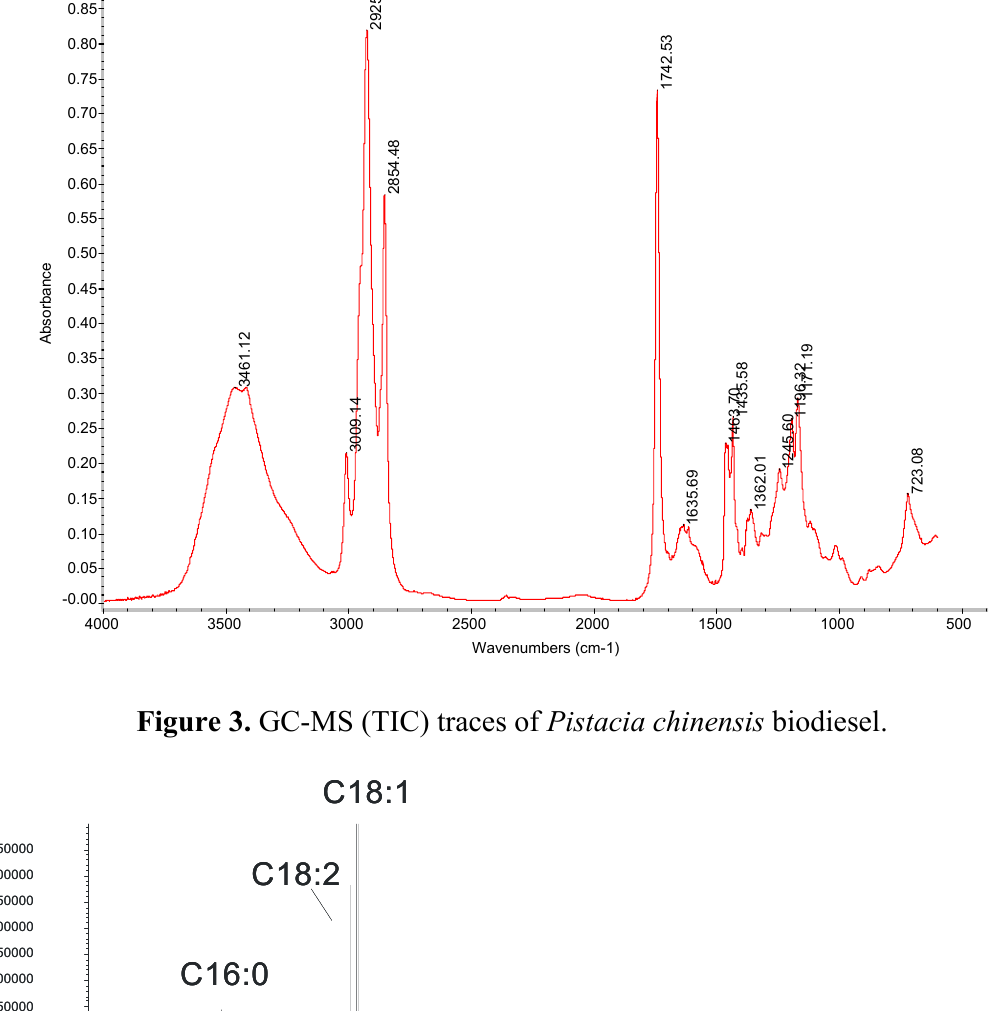
Figure 2. FTIR spectrum of Pistacia chinensis biodiesel.